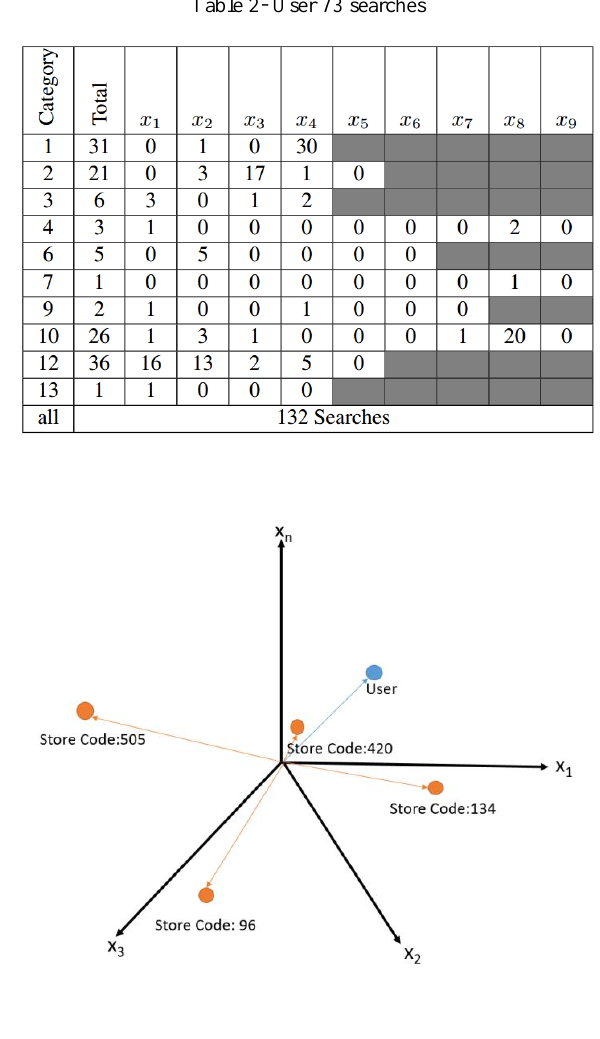
Figure 4- The user's feature vector in clothes category and four clothes